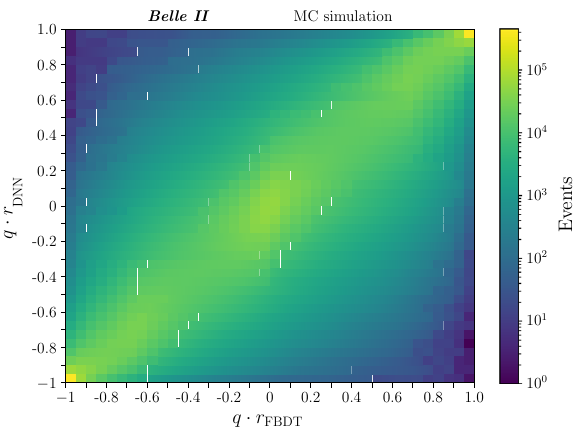
Fig. 4 Distribution of the DNN tagger output vs. the category- based(FBDT)taggeroutputinthetesting B 0 → ν τ ν τ